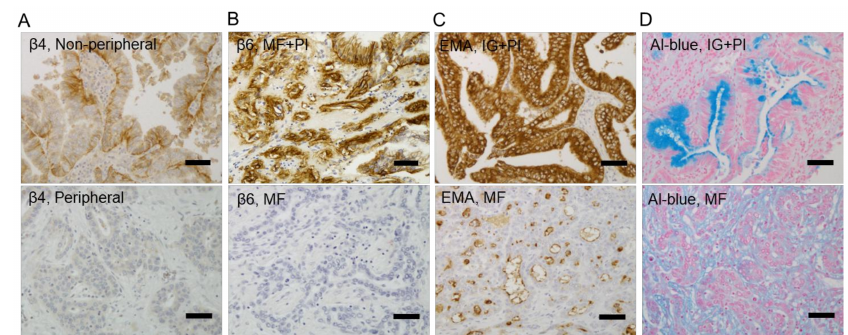
Figure 2. The expressions of β 4 and β 6 integrin in association with the localization and macroscopic types of intrahepatic cholangiocarcinoma. β 4 and β 6 integrin expression levels are higher in the non-peripheral central localization type than in the peripheral localization type intrahepatic cholangiocarcinoma (ICC) ( A ), and higher in the intraductal-growth and periductal-infiltrating types (IG+PI) than in the mass-forming type (MF) intrahepatic cholangiocarcinoma ( B ). A cytoplasmic epithelial membrane antigen (EMA)-positive pattern and Alcian blue (Al-blue)-positive intracytoplasmic dense mucus staining were observed in the high-integrin expression groups, including IG+PI, while a luminal EMA positive pattern and faint Alcian blue-positive mucus staining were evident in the low-integrin expression groups, including the MF group ( C , D ). Scale bar, 50 µ m. Original magnification, ×